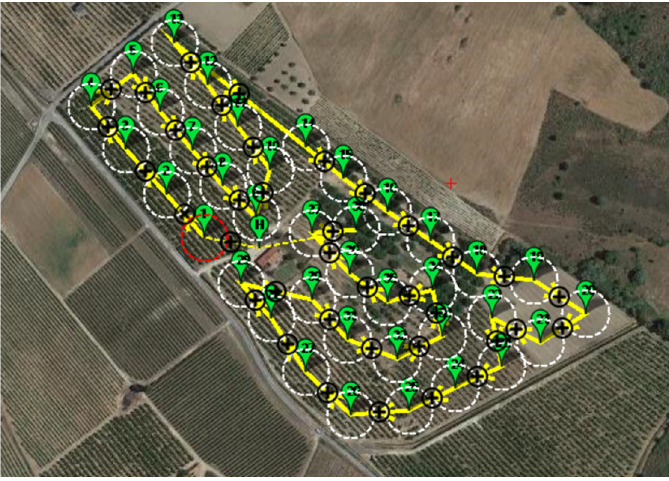
Figure 8. PoIs of the Case Study #1.